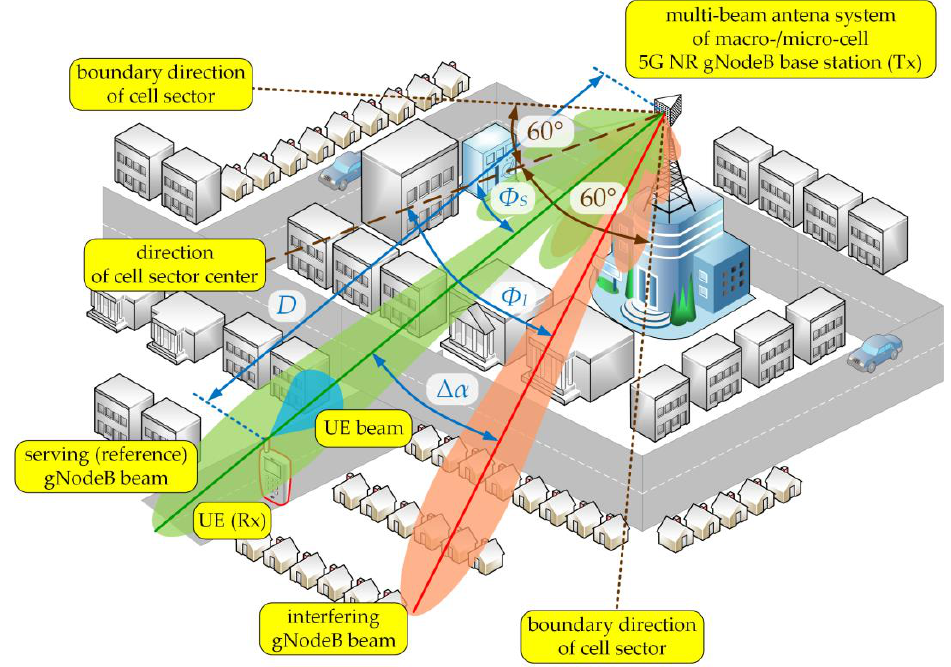
Figure 2. DL spatial scenario of simulation studies [32].